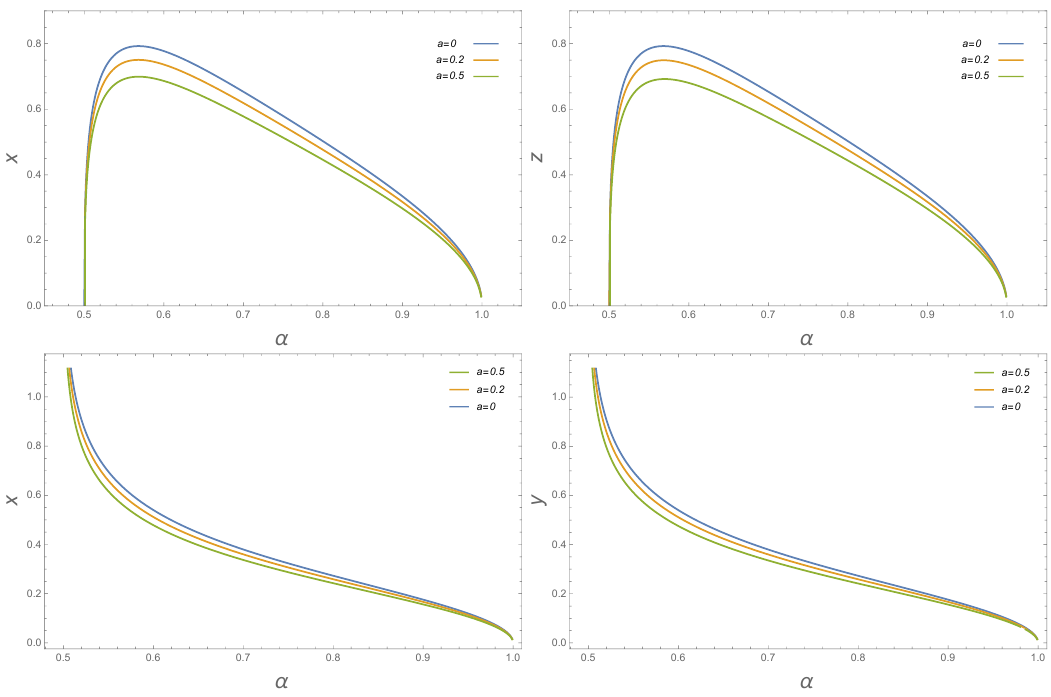
Figure 2 . The separation as a function of α . Upper: the separation x, z as a function of α in the black brane solution. Lower: the separation x, y as a function of α in the bubble